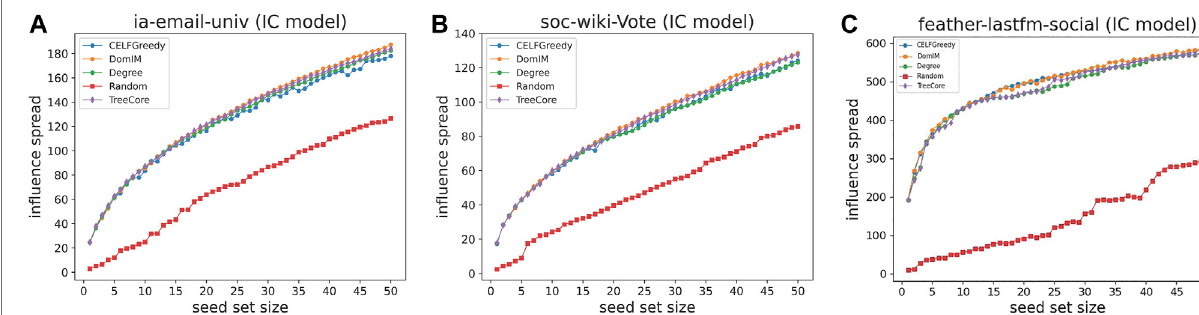
FIGURE 2 | Results of in fl uence spread under IC model.